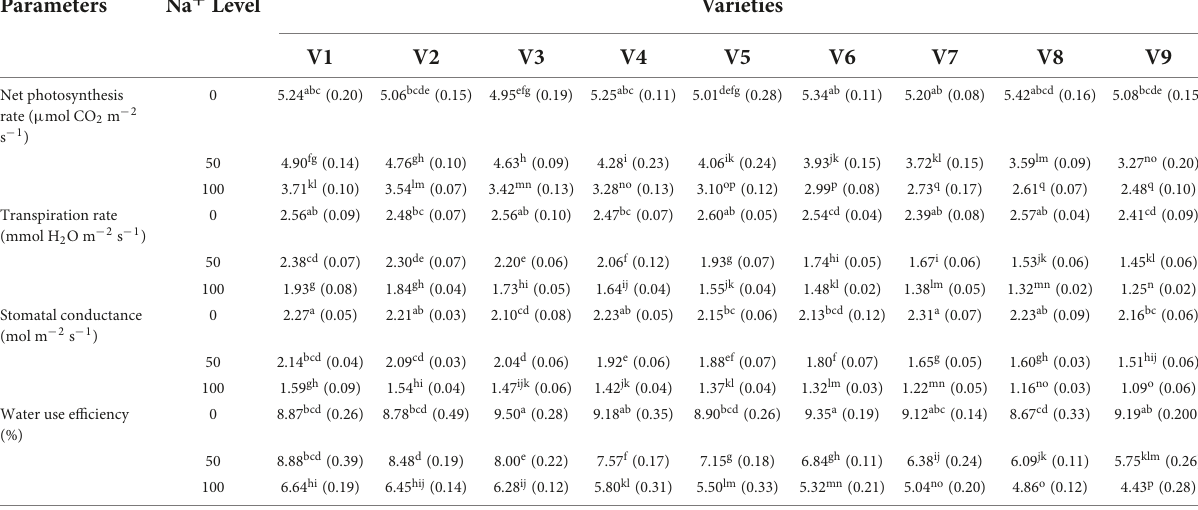
TABLE 1 Effect of different concentrations of NaCl on gas exchange parameters of different barley genotypes. Parameters Na + Level